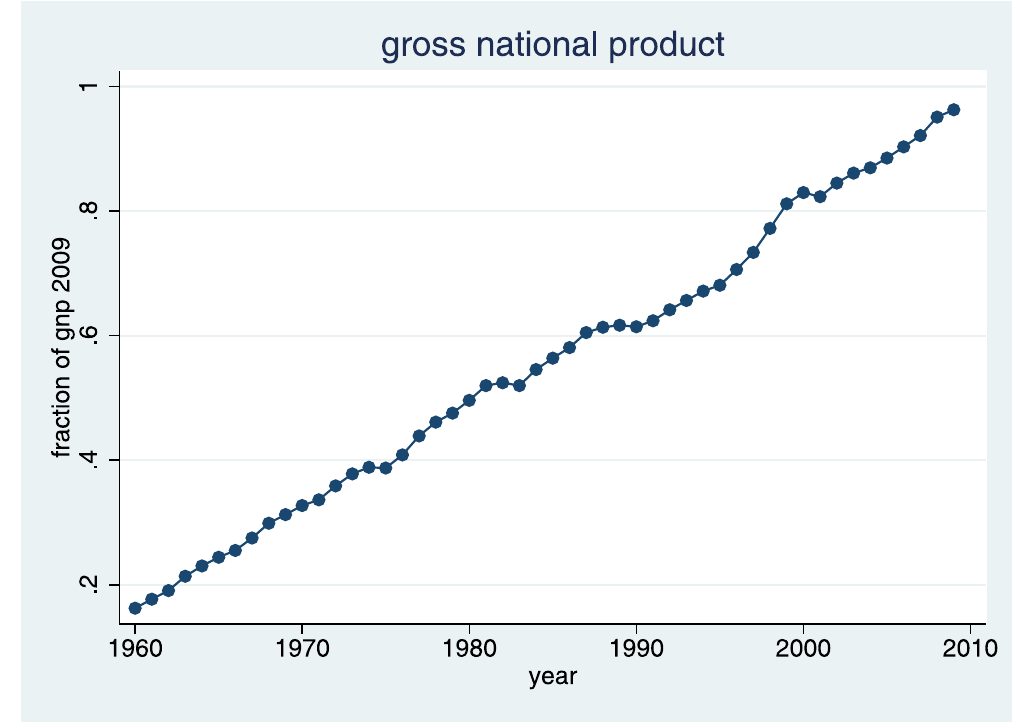
Fig 9. GNP Development as a Proxy for earning Prospects in Law